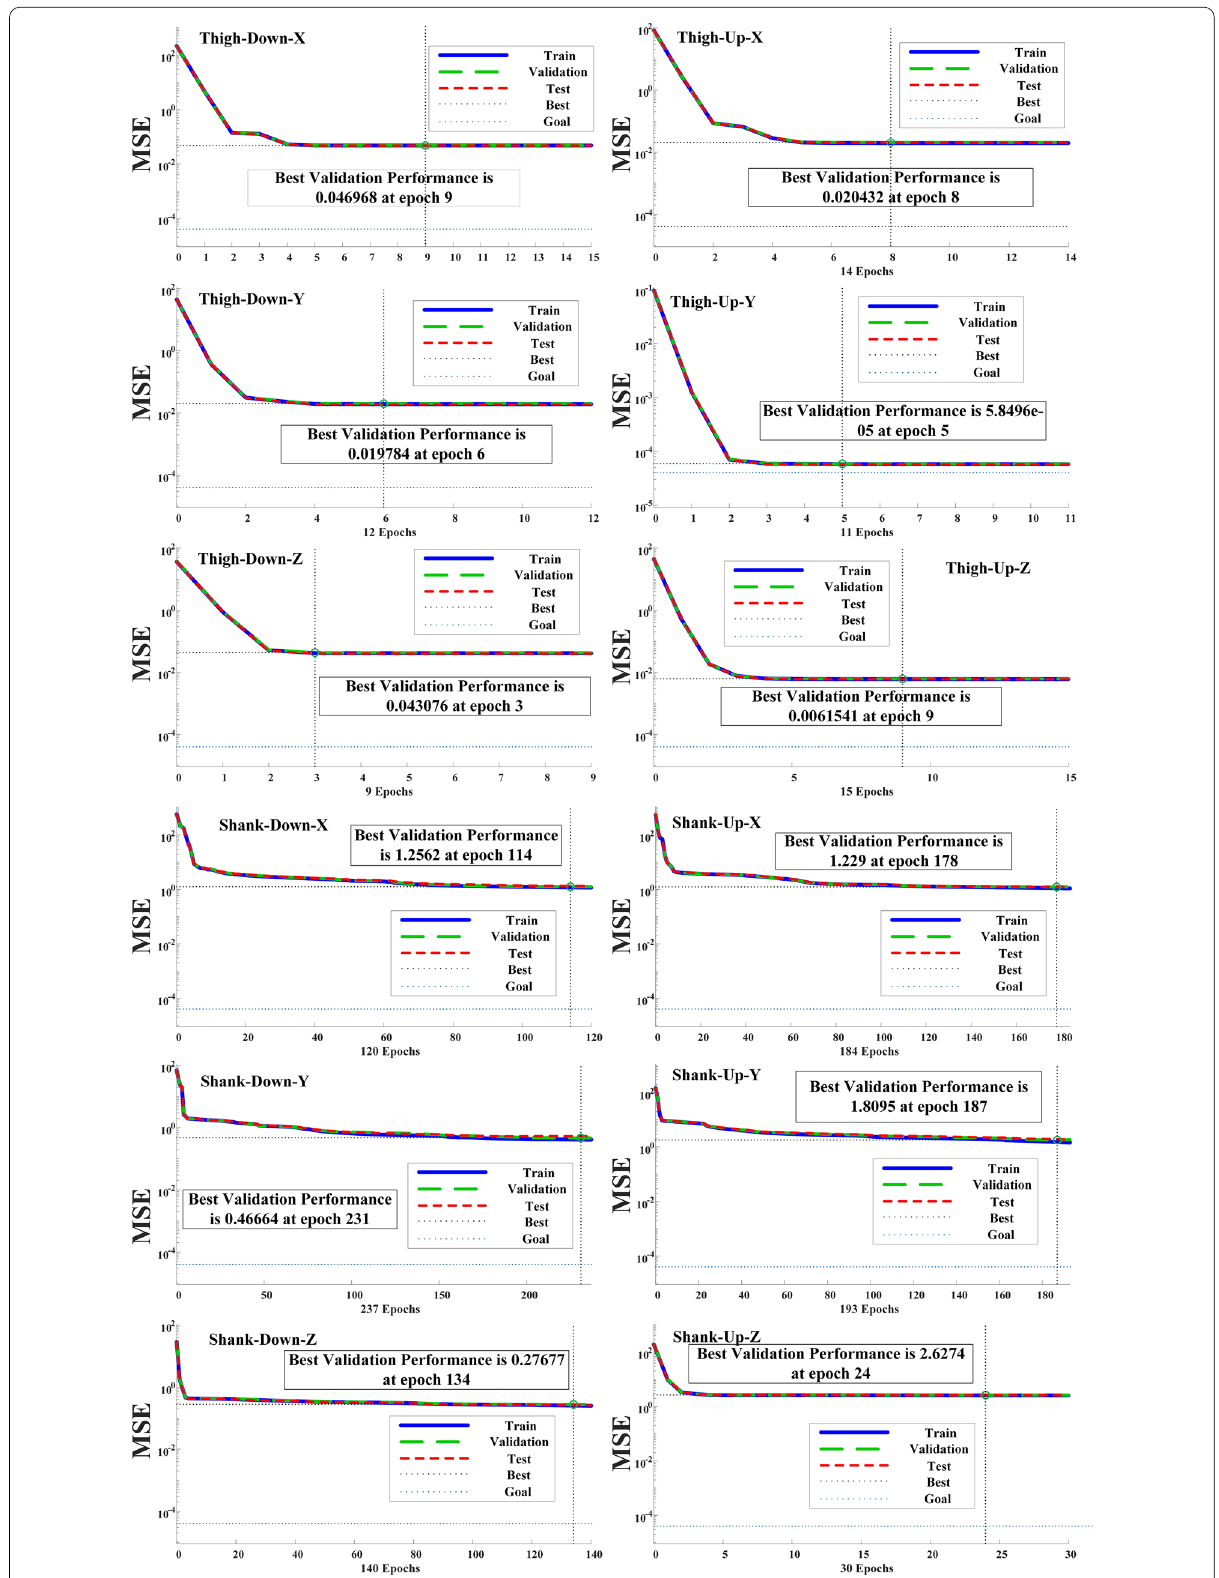
Figure 9 Training process of BP neural